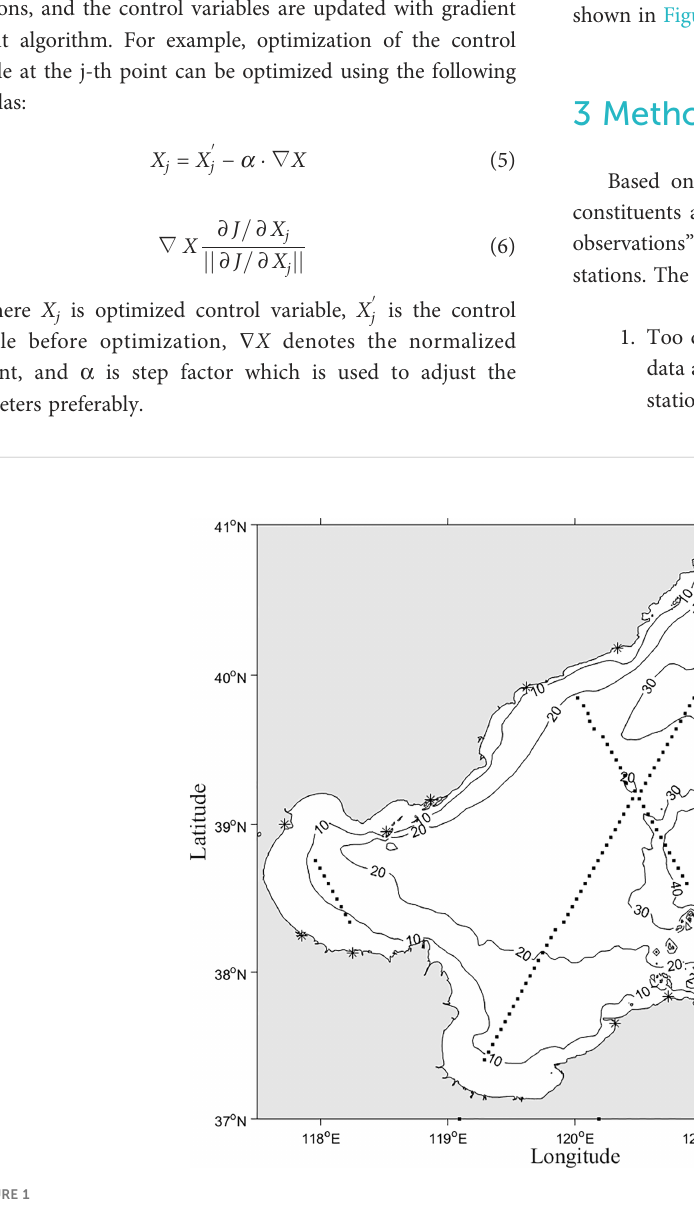
FIGURE 1 Bathymetry map of Bohai Sea and the position of tidal stations (asterisks), T/P-Jason altimeter tracks are denoted (points) and open boundaries